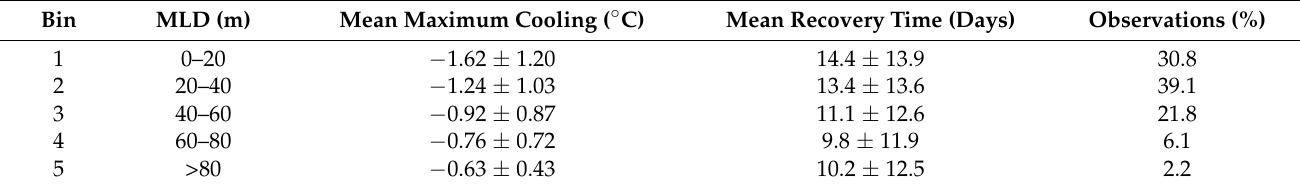
Figure 4. The composite time series of TC-induced SST cooling relative to ( a ) the day of TC passage and ( b ) the day of maximum cooling based on different recovery time. Table 1. The average and standard deviation of maximum cooling and recovery time and the observational frequency distributions (%) for different MLD